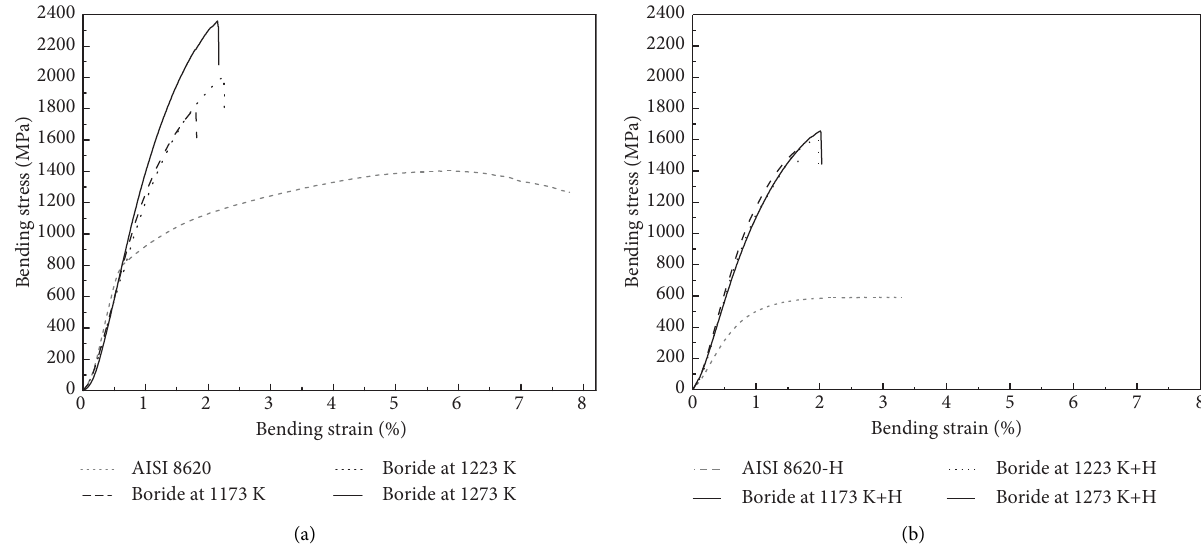
Figure 9: Bending stress vs. bending strain curves obtained during slow bending tests of boride and unborided AISI 8620 steel (a) without hydrogen permeation and (b) with hydrogen permeation. Table 2: Tree-point bending test result of AISI 8620 steels samples without and with hydrogen permeation. Test